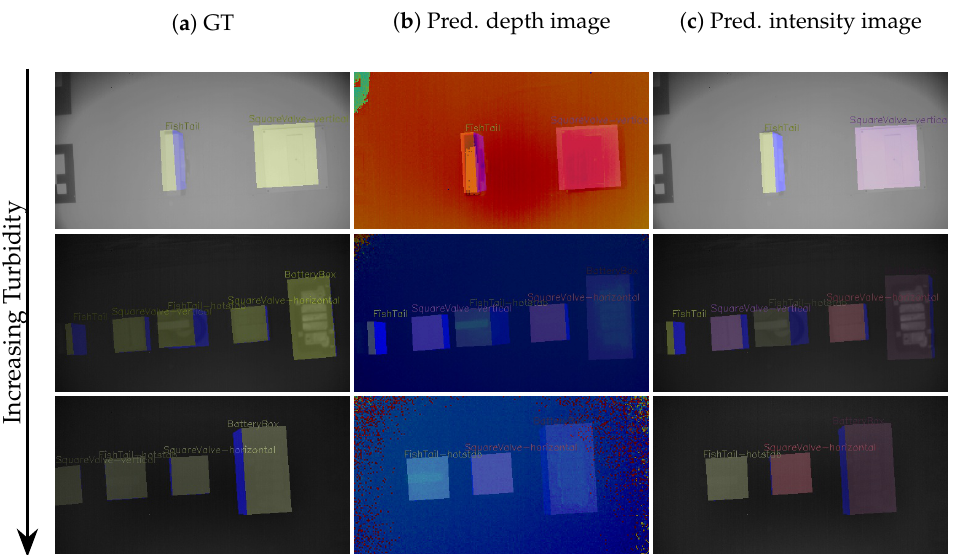
Figure 5. Qualitative results for detection and pose estimation: The first column ( a ) shows ground truth pose projected on the intensity images. Column two ( b ) and three ( c ) shows the estimated pose projected on the depth and intensity image, respectively. The top, middle and last row shows ground truth and predicted pose result for turbidities 1, 3 and 6. The last row shows miss-detection (i.e., four object in GT and three detected objects in the prediction) under partial occlusion and low depth resolution. The processing time for a single frame is 62.5 ms or 16 frames per second using a single GPU (GeForce RTX 2080 Ti, 11 GB).